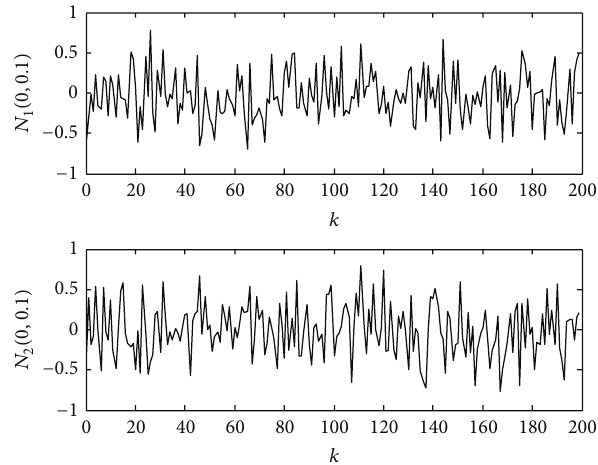
Figure 2: Gaussian noises 𝑁 1 (0,0.1) and 𝑁 2 (0, 0.1) for Example 2.